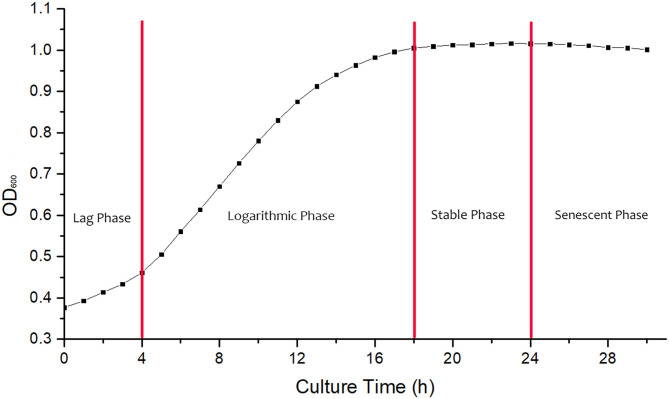
The growth curve of strain in culture.